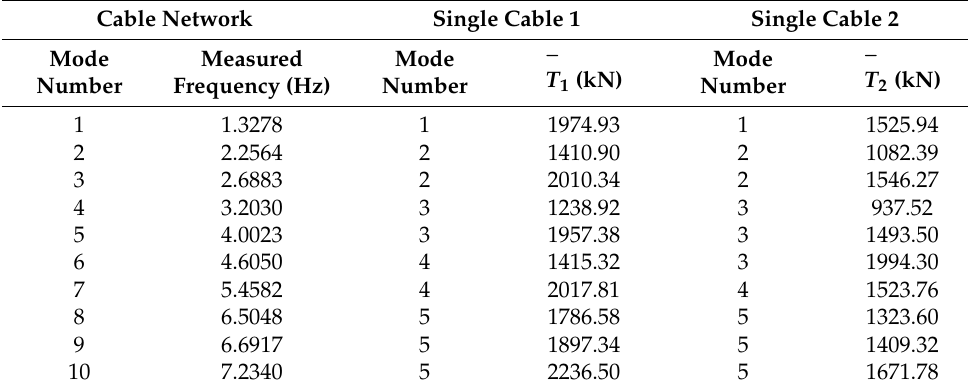
Table 2. The predicted values of cable